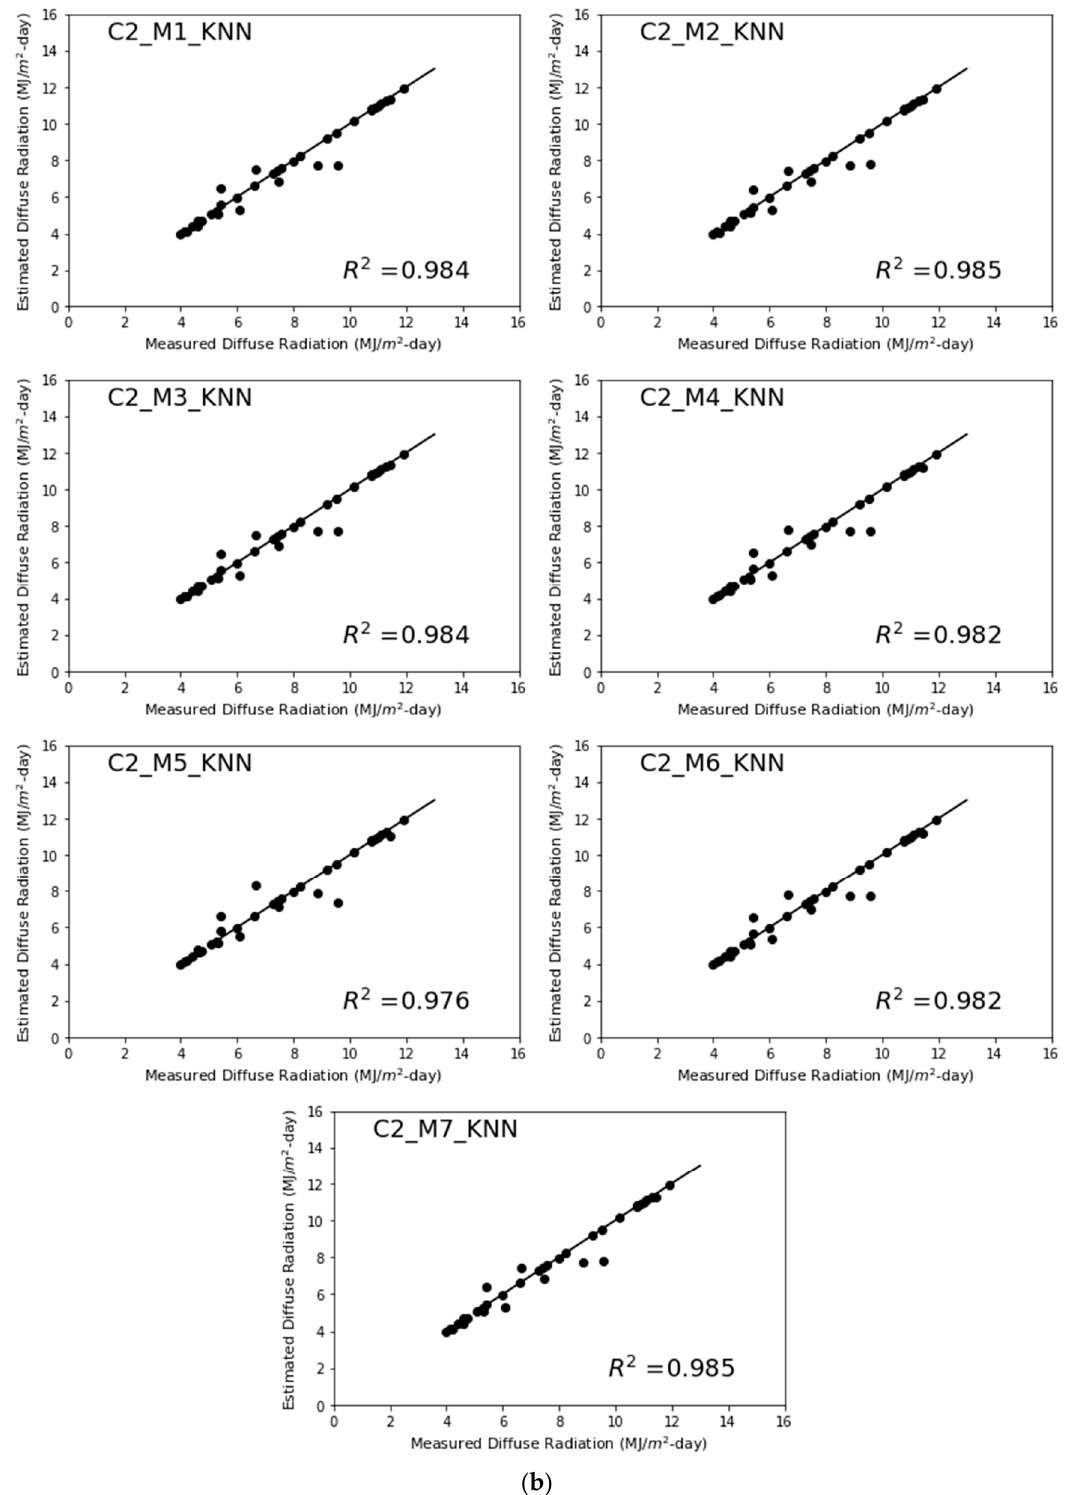
Figure 12. ( a ) Plot depicting predicted and measured DSR Arid climate (Category I). ( b ) Plot depicting predicted and measured DSR Arid climate (Category I).